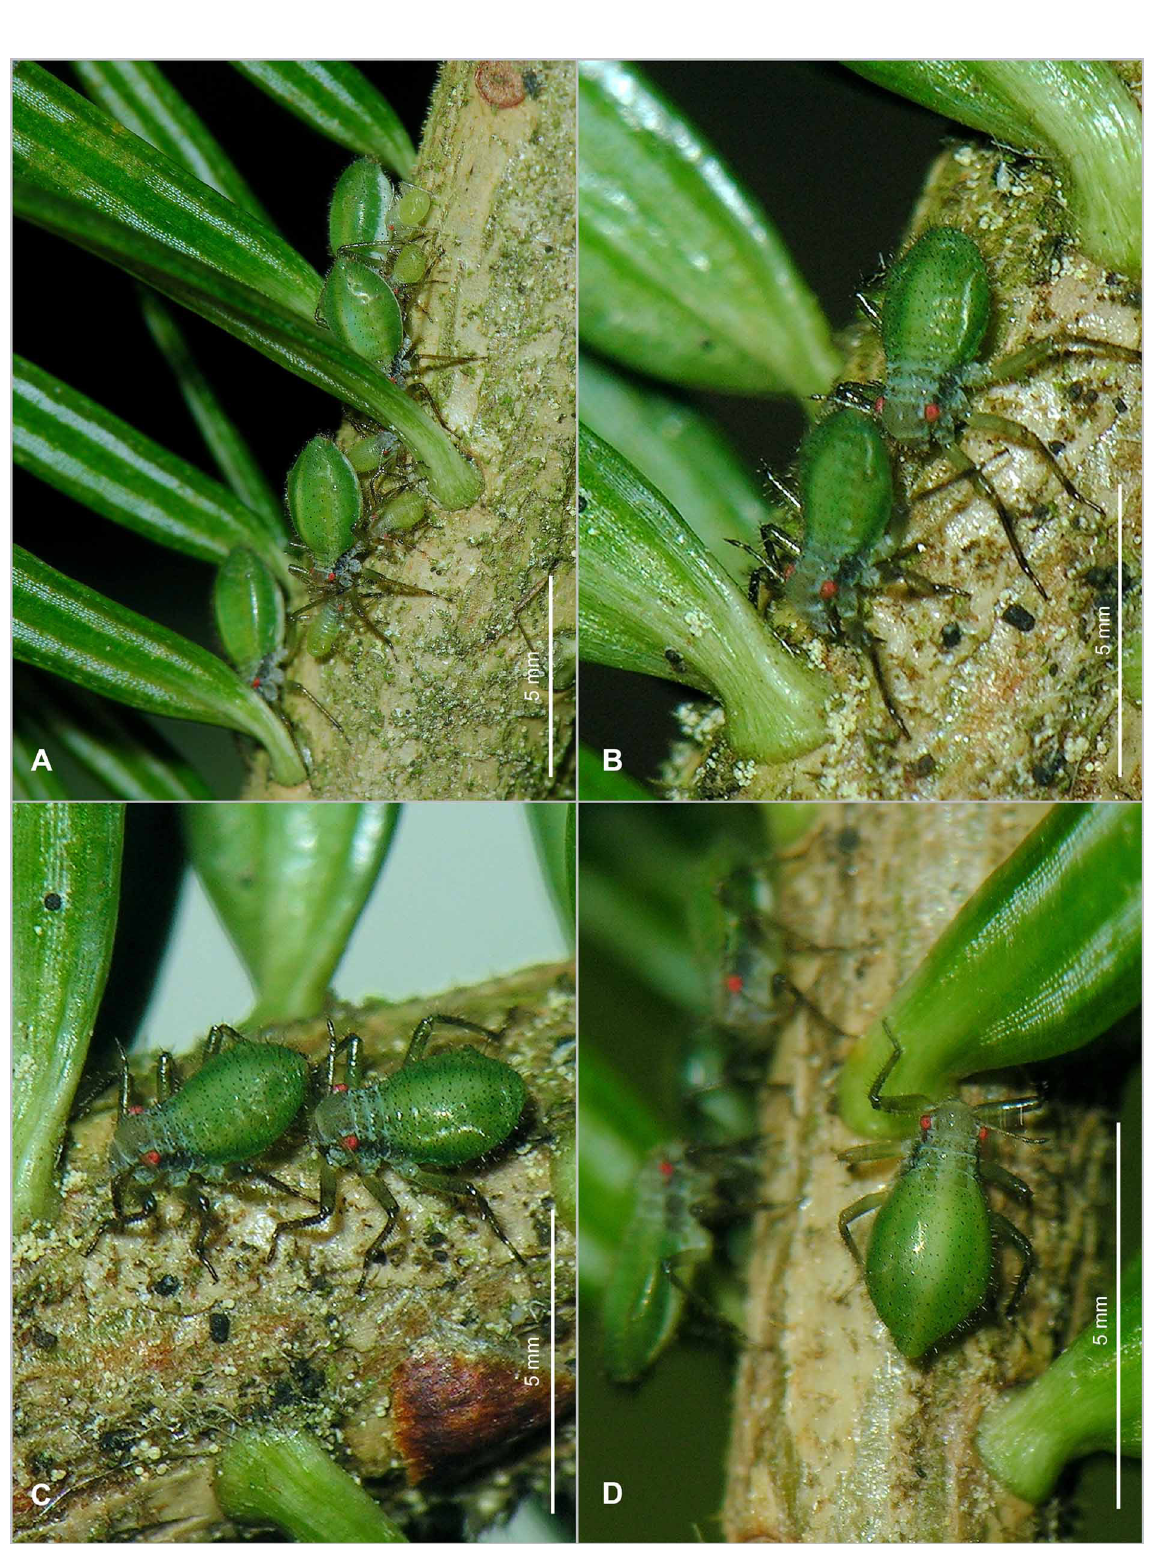
Fig. 55. Cinara (Cinara) pectinatae Nördlinger, 1880. Colonies (mostly juv.) on trunk and branches of young Abies alba